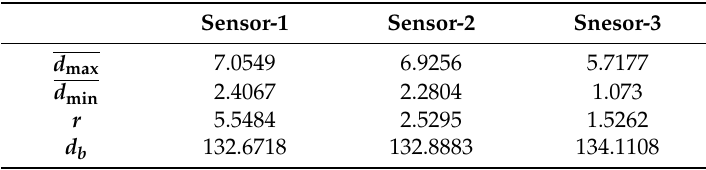
Table 1. Base radius and tangential radius